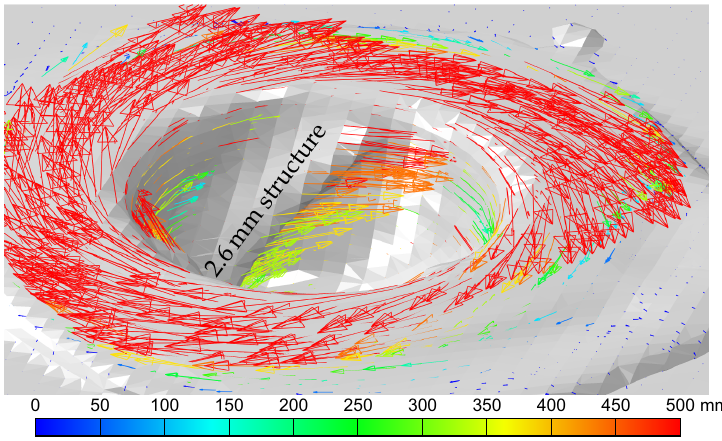
Figure 12. Material flow induced by the 2.6mm wide structures of the fifth tool design iteration in the area of pin regime and former stagnation point. Tool not